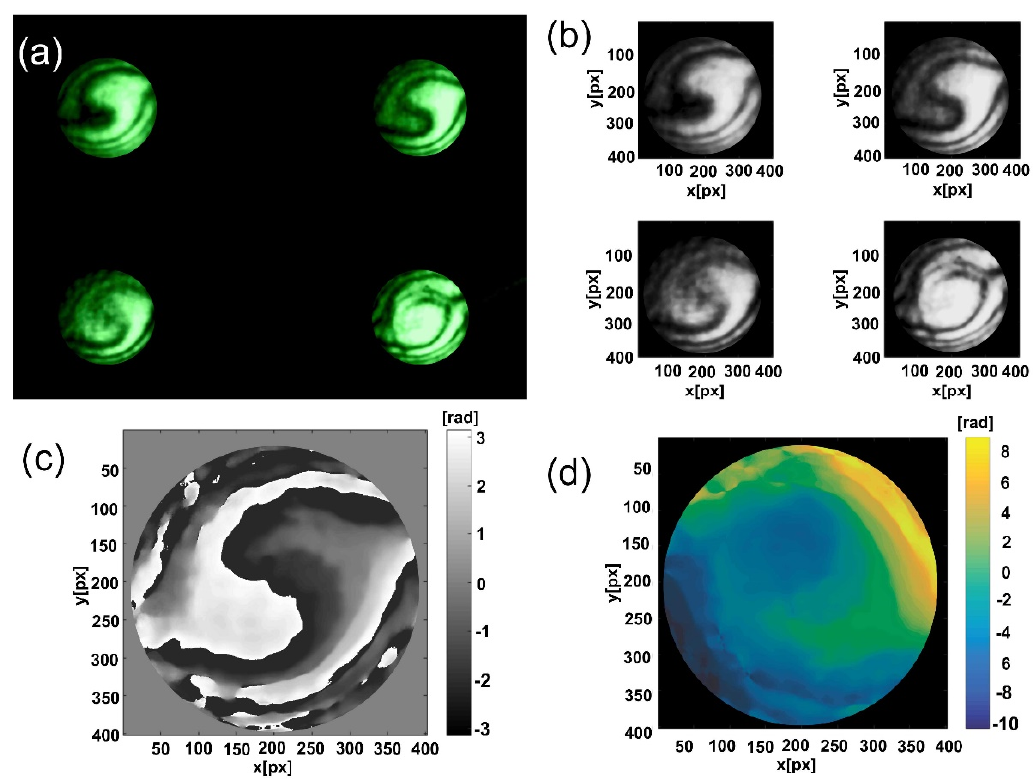
Figure 5. Lens out of focus and off the optical axis. ( a , b ) Four simultaneous patterns. ( c ) Wrapped phase. ( d ) Phase map.